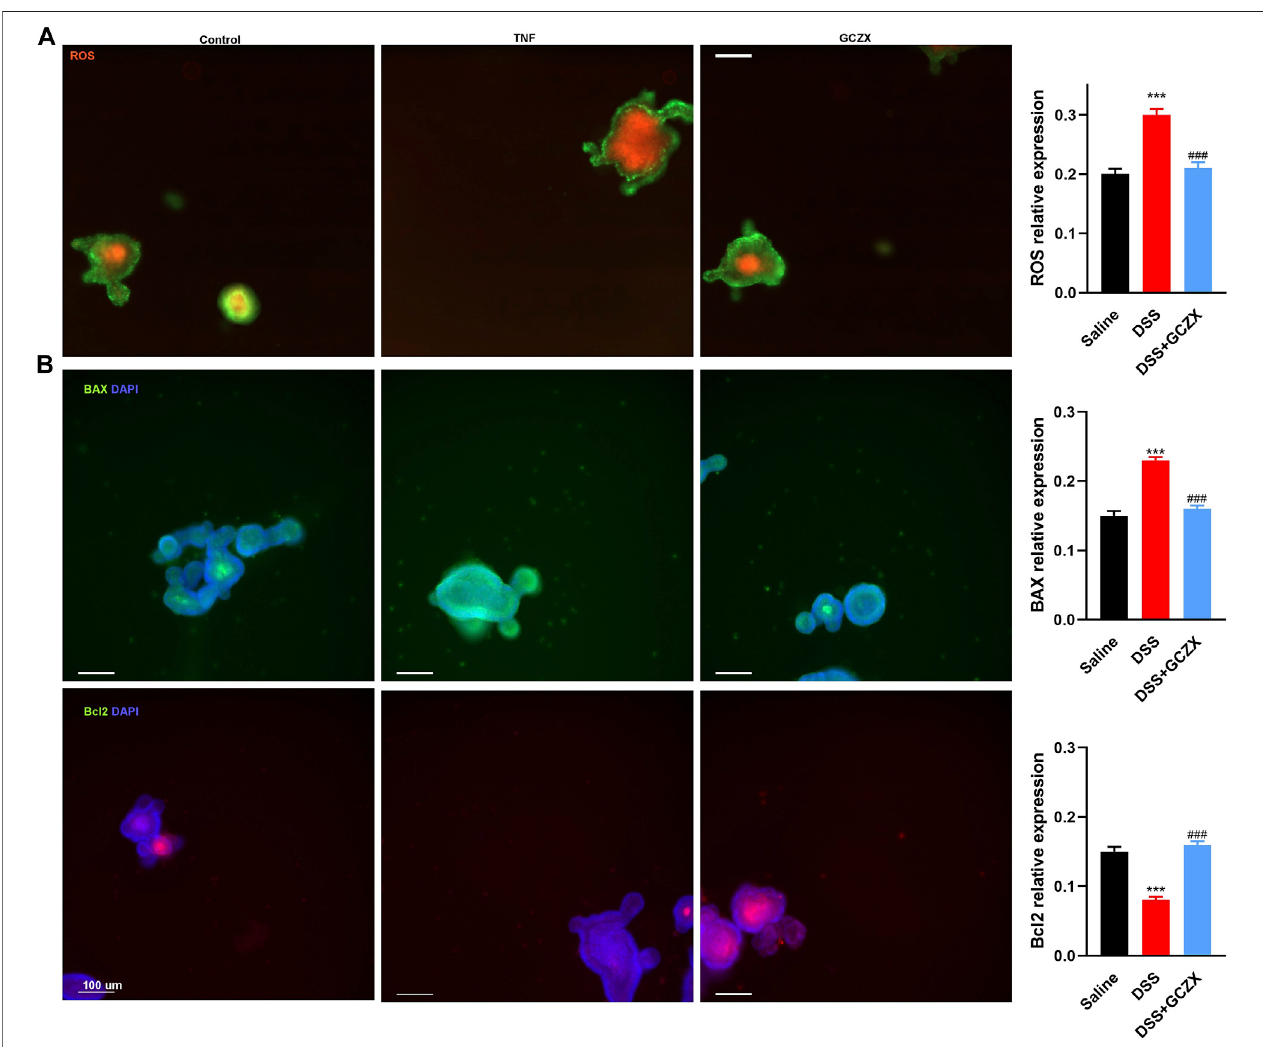
FIGURE 8 | GCZX treatment alleviates TNF α -induced apoptosis of intestinal organoids. Immuno fl uorescent staining illustrating the mitochondrial stress (A) and BAX as well as BCL-2 expression (B) of TNF α -treated (20 ng/ml, 24 h) intestinal organoids in the presence of GCZX (30 ng/ml, 24 h). * p < 0.05, ** p < 0.01, and *** p < 0.001 indicates a statistically signi fi cant difference from saline group; # indicate statistically signi fi cant difference from UC group.